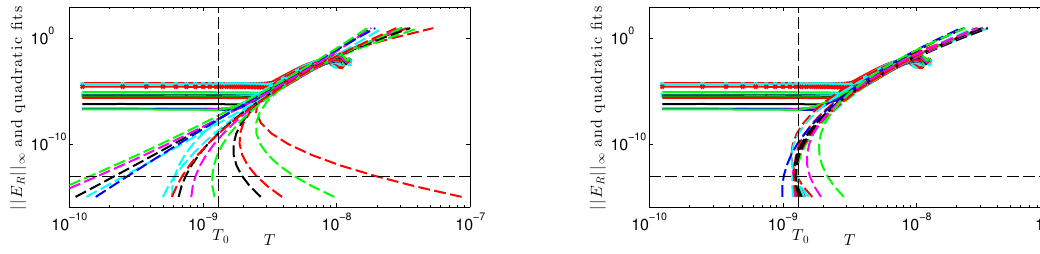
Figure 17. Left panel: extrapolated quadratic curves based on the initial fitting range in the stripline example. Right panel: extrapolated quadratic curves based on a more narrow fitting range in the stripline example. The average time delay is T ( aver )